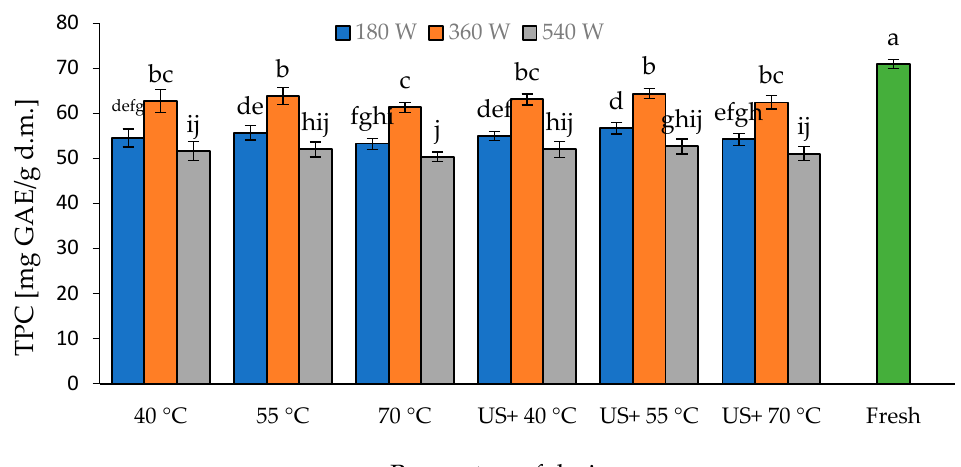
Figure 6. Effects of US pretreatment, MW power and air temperature during drying on total polyphe- nol content (TPC) in hawthorn. Data followed by different letters (a–j) in each column are significantly different at p < 0.01. Columns with the same letters are not significantly different.